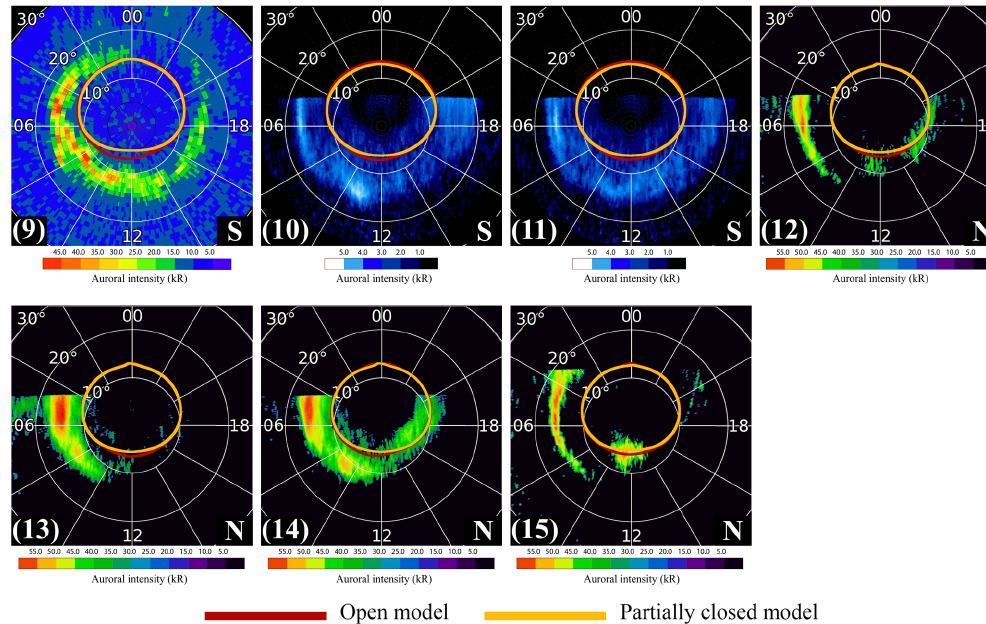
Figure 3. Saturn UV auroral images obtained by the HST for northward IMF in the same format as Fig.